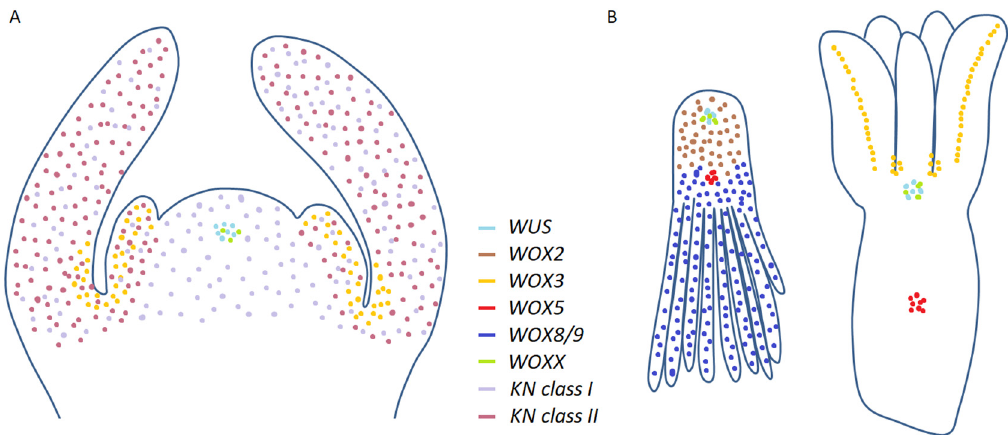
Figure 3. Schematic representation of the expression domains of some WOX and KNOX genes in conifers according to quantitative real-time PCR, RNA sequencing RNA-seq and in situ mRNA hybridization results. ( A ) Shoot apex; ( B ) late and mature somatic embryo. Source: unpublished drawings from the authors.